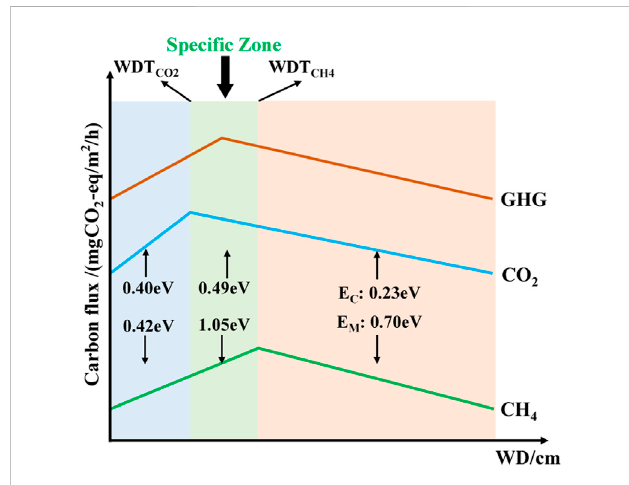
FIGURE 6 Relationship comparison of carbon emissions varying with water depth and carbon emissions responding to